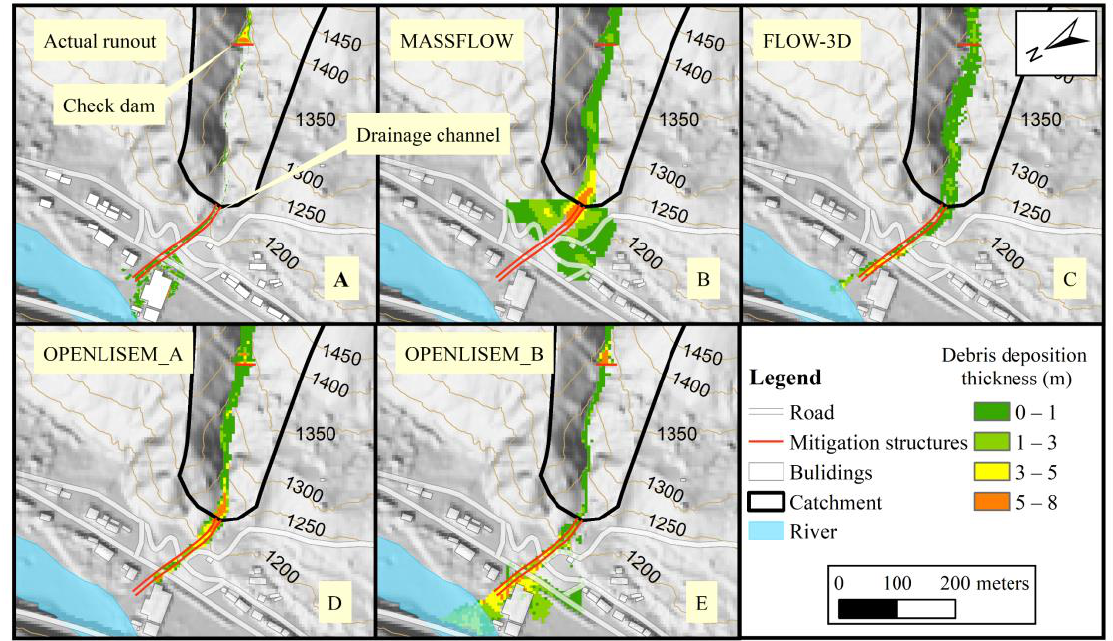
Figure 11. Debris flow runout in 2020: actual runout ( A ) and simulations by Massflow ( B ), Flow-3D ( C ), OpenLISEM_A ( D ), OpenLISEM_B ( E ).